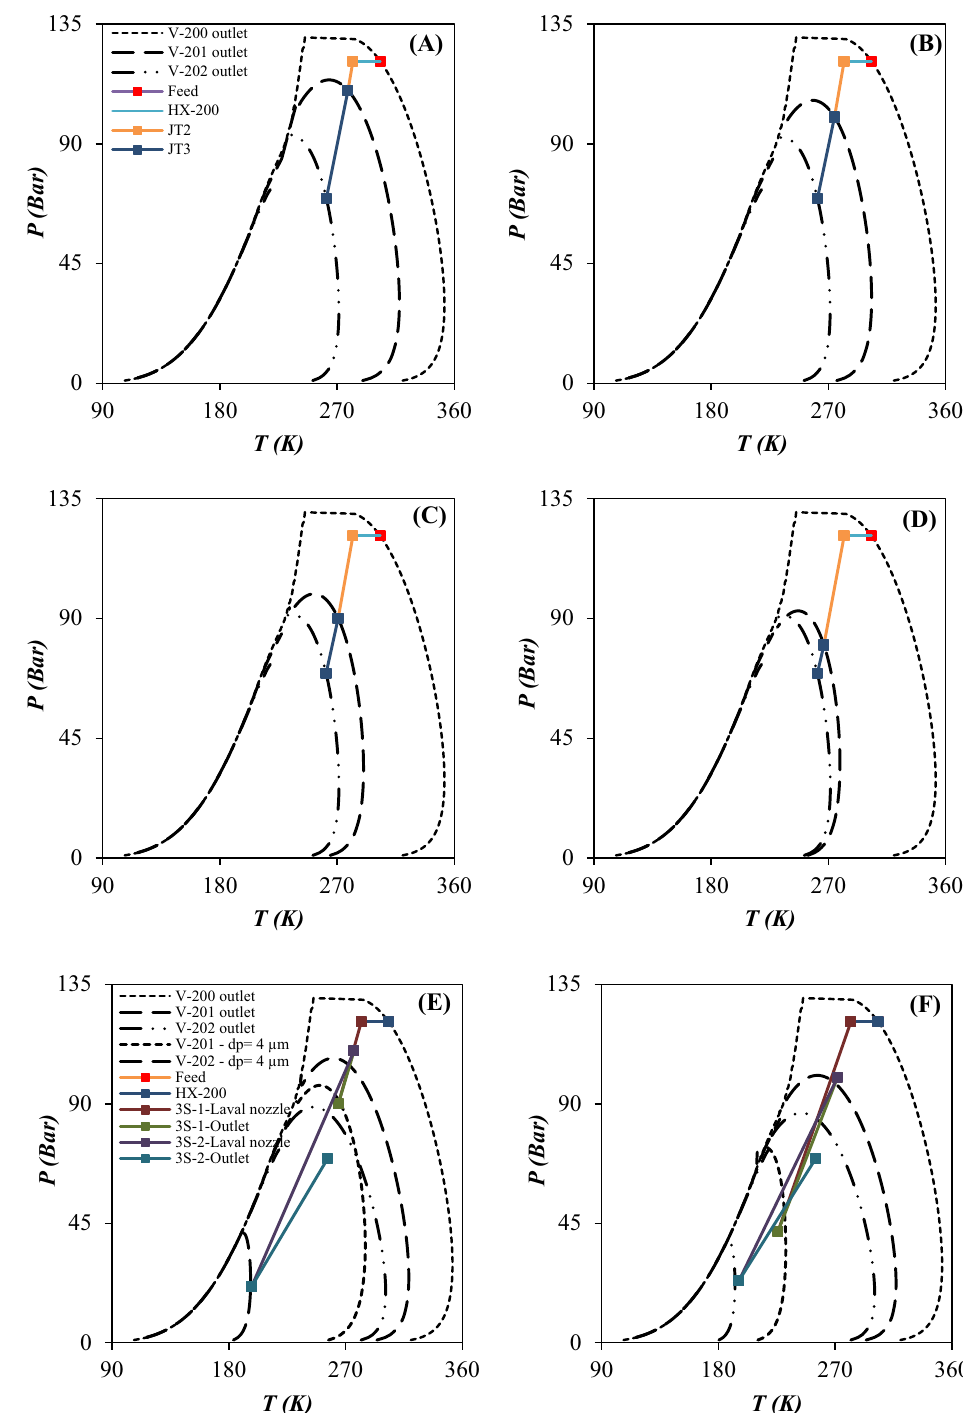
Figure 10. PED for configuration A ( A–D ) and D ( E–H ): ( A, E ) Scenario 1, ( B, F ) Scenario 2, ( C, G ) Scenario 3 and ( D, H ) Scenario